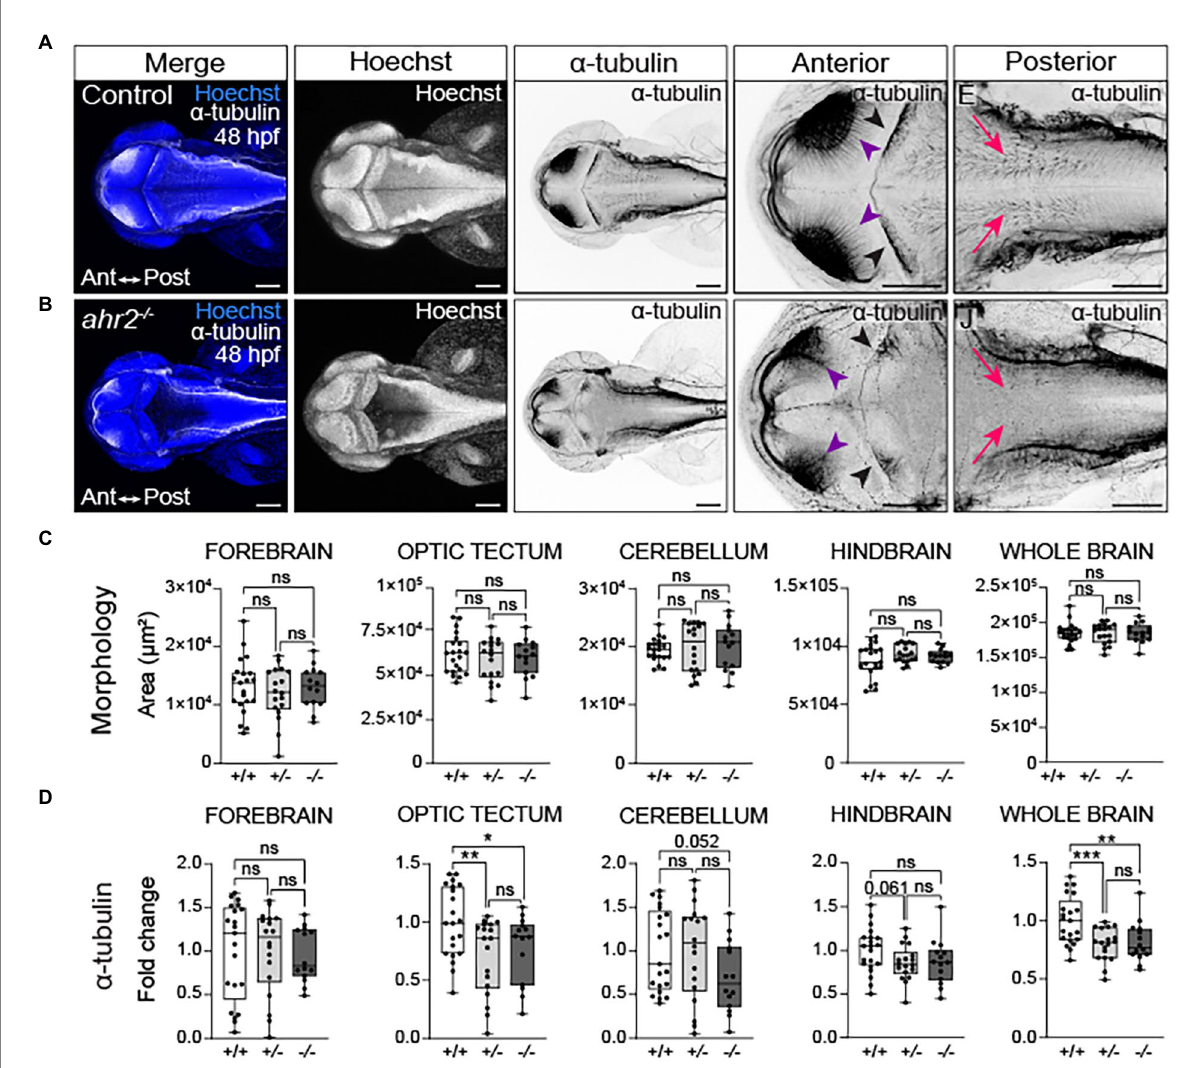
FIGURE 8 Loss of ahr2 disrupts neural network formation without affecting brain size. Dorsal views of control (A) and homozygous ahr2 mutant embryos (B) at 48 hpf stained with Hoechst (DNA, blue) to visualize the parenchyma and immunolabeled with an anti-acetylated α -tubulin antibody to mark axon tracts (white and inverted to black). (C) Area measurements of the forebrain, optic tectum, cerebellum, hindbrain, and whole brain at 48 hpf in wild-type ahr2 , heterozygous ahr2 , and homozygous ahr2 mutant embryos. (D) Fold change of acetylated α -tubulin in the forebrain, optic tectum, cerebellum, hindbrain, and whole brain of heterozygous ahr2 , and homozygous ahr2 mutant embryos zebrafish relative to the mean acetylated α -tubulin area coverage of wild-type embryos. There were no apparent differences in the size of the forebrain, optic tectum, cerebellum, hindbrain, and whole brain in mutants when compared to controls (C) ; however, acetylated α -tubulin coverage was significantly reduced in the optic tectum (purple arrowheads) and the whole brain of homozygous and heterozygous ahr2 mutant embryos embryos relative to controls (D) . Acetylated α -tubulin coverage in the cerebellum (black arrowheads) and hindbrain (pink arrowheads) was also reduced, but this was not a statistically significant finding with the analysis pipeline used for quantification (D) . Statistical significance determined by Welch’s t-test, * p < 0.05, ** p < 0.01, *** p < 0.001. n = 14–21 fish/group across 3 replicates. Anterior is left in all confocal micrographs. Scale bar = 100 μ m. Magnification = 10x with varying